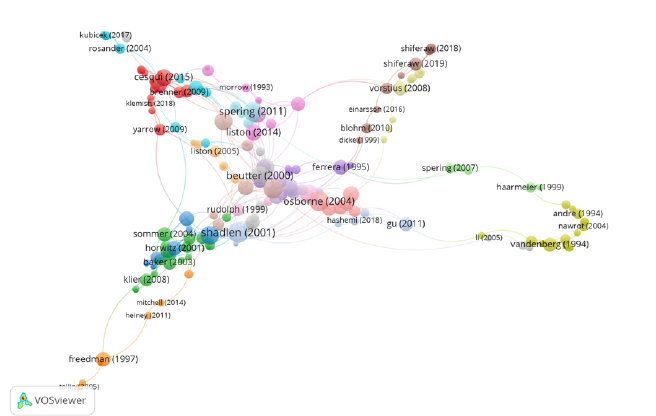
Figure 9. Citation network in Group 7